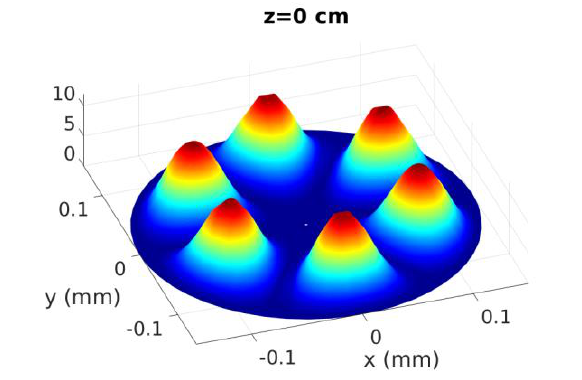
Fig. 1. Transverse profile of the input necklace beam mode with 6